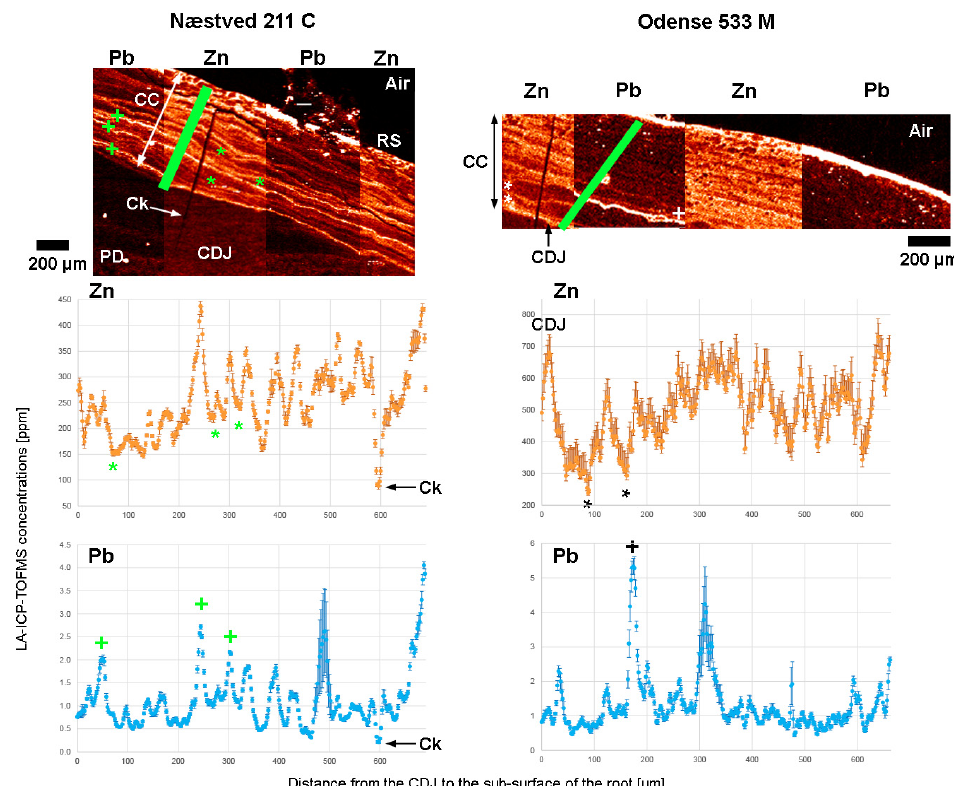
Figure 6. Covariation of Pb and Zn in the cellular cementum of Næstved 211C ( left ) and Odense 533M ( right ) (LA-ICP-TOFMS data used for the correlation tests, File S1). Note that two Zn depletions (black star on the graph, white star on the map) are followed by a Pb enrichment (black cross on the graph, white cross on the map) in Odense 533M, while three Pb enrichments (green cross) are followed by Zn depletions (green star) in Næstved 211C. The range of the y -axes has been adapted to best present the fluctuations of Zn and Pb in the two teeth. The root surface is enriched in Pb over the first ~30µm, which were avoided here to best represent the elemental covariations. Error bars represent 1 SD on either side. “CC” stands for “cellular cementum,” “CDJ” for “cementodentine junction,” “PD” for “primary dentine,” “RS” for “root surface,” “Ck” for “crack” in the cellular cementum of Næstved 211C. Graphic programs used: Adobe Photoshop CS6 and Adobe Illustrator CS6.